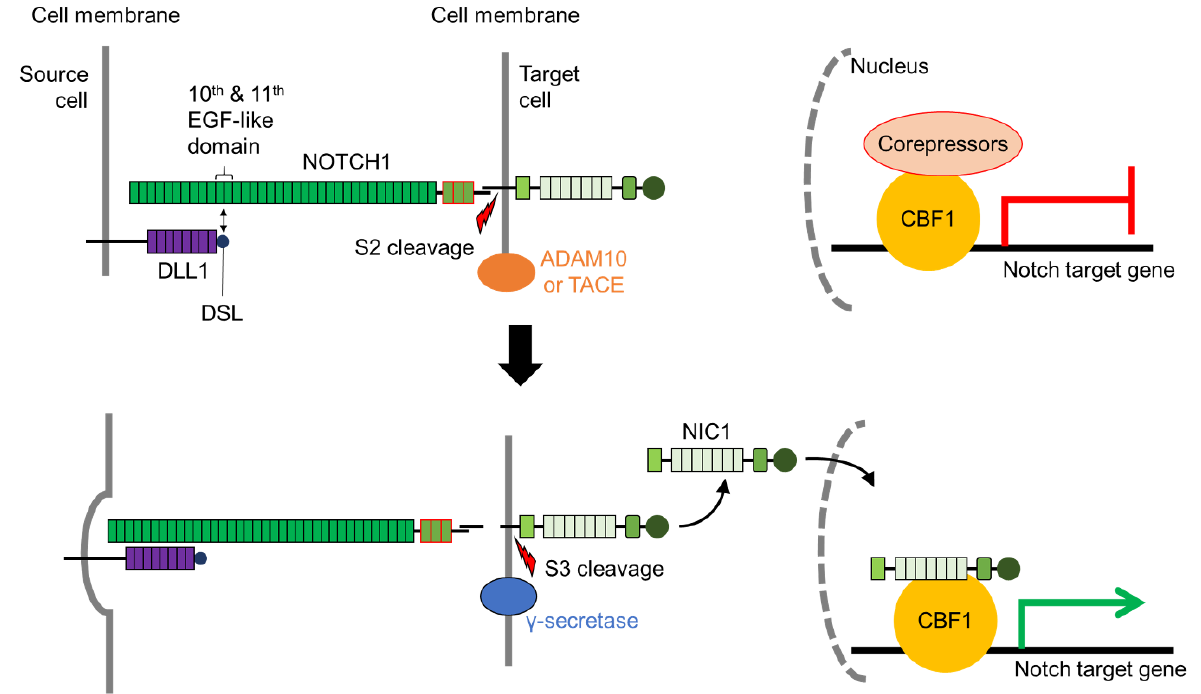
Figure 2. Trans-interaction of receptor and ligand activation of Notch signaling results in the transcription of CBF1-bound Notch target genes. Interaction of DELTA-LIKE1 (DLL1) DSL domain with the 10th and 11th EGF-like domain activates endocytosis by the source cell. This exposes the S2 site for cleavage by ADAM10 or TACE. Prior to Notch activation, Notch target genes are silenced by the recruitment of corepressors to CBF1. S2 cleavage exposes key amino acids to S3 cleavage by γ -secretase, releasing NIC1 into the nucleus of the target cell. NIC1 binds to CBF1 and displaces corepressors to upregulate Notch target gene expression. ADAM10: A disintegrin and metalloprotease 10; CBF1: C-promoter binding factor 1 (also termed RBPjκ); EGF -like: Epidermal growth factor-like; NIC1: Intracellular domain of NOTCH1; TACE: ADAM17/Tumor necrosis factor- α converting enzyme.